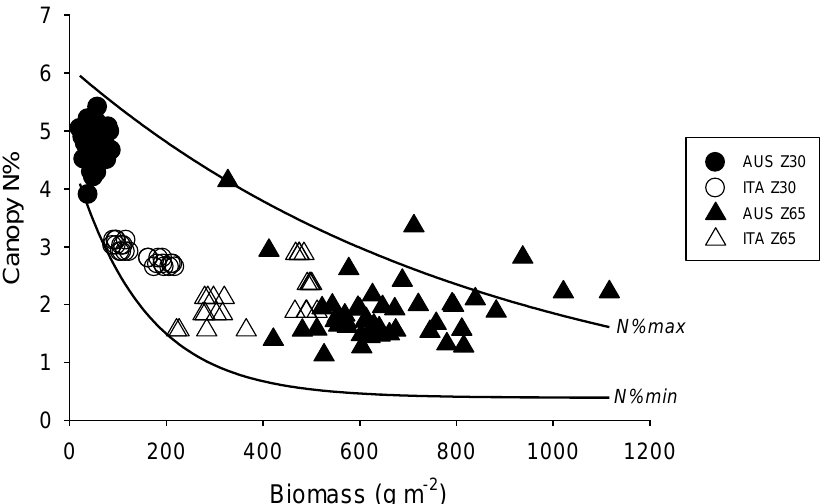
Figure 1. The relationship between canopy nitrogen (N) concentration (%) and biomass (g∙m −2 ) for Australia and Italy at the pseudo-stem elongation (Z30) and anthesis (Z65) stages. The N% and N% were calculated following the approach of [50]. AUS, max min Australia; ITA,